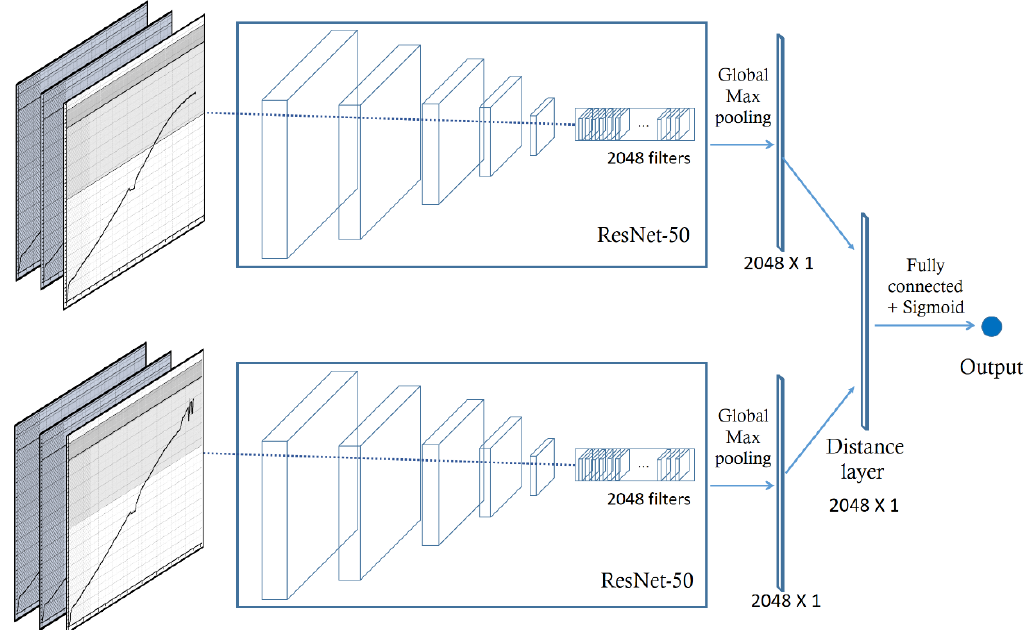
Figure 6. The architecture of the SNN is used in this study. The two images from the same class are called a positive pair, and those from the different classes are called a negative pair. This network is mainly based on the well-known ResNet-50.